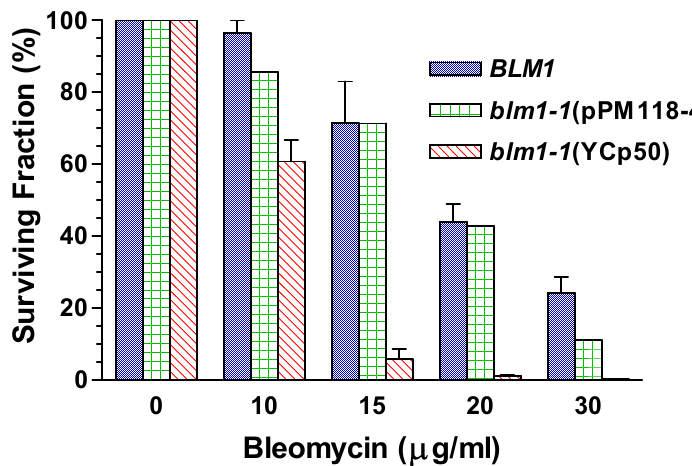
Figure 4. A representative comparison of the resistance of normal ( BLM1, CM1401-5B) and transformed blm1-1 mutant strains to lethal effects of bleomycin. The blm1-1 mutant strain, CM1401- 5C, was transformed with the plasmid (pPM118-4) or with the YCp50 vector alone. The normal segregant and the transformed mutant strains were plated on supplemented SD medium containing various concentrations of bleomycin. Plates were incubated at 30 o C for 3 days. The survival value of the last cell is 0.3 ±